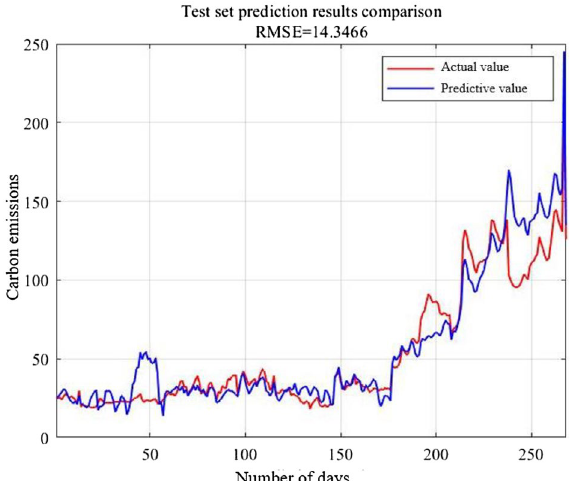
Figure 6. Prediction comparison of testing set.